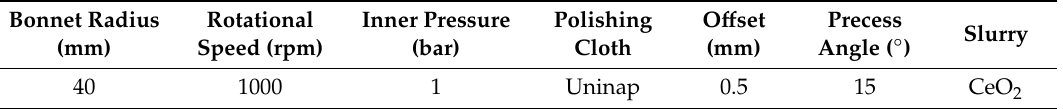
Figure 3. Experimental setup of BP. Table 2. Processing parameters of BP.